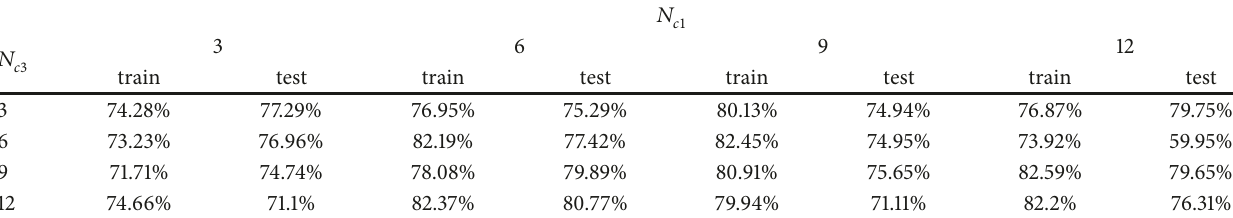
Table 2: Classification rates of CNN under different number of feature maps.